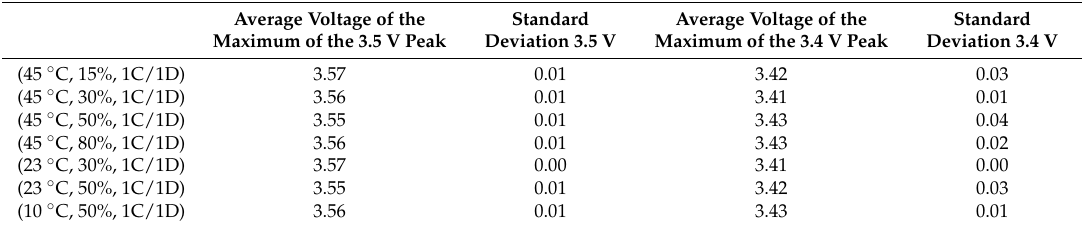
Table 3. Average value of voltage and standard deviation for 3.5 V and 3.4 V peak maxima. Average Voltage of the Maximum of the 3.5 V Peak